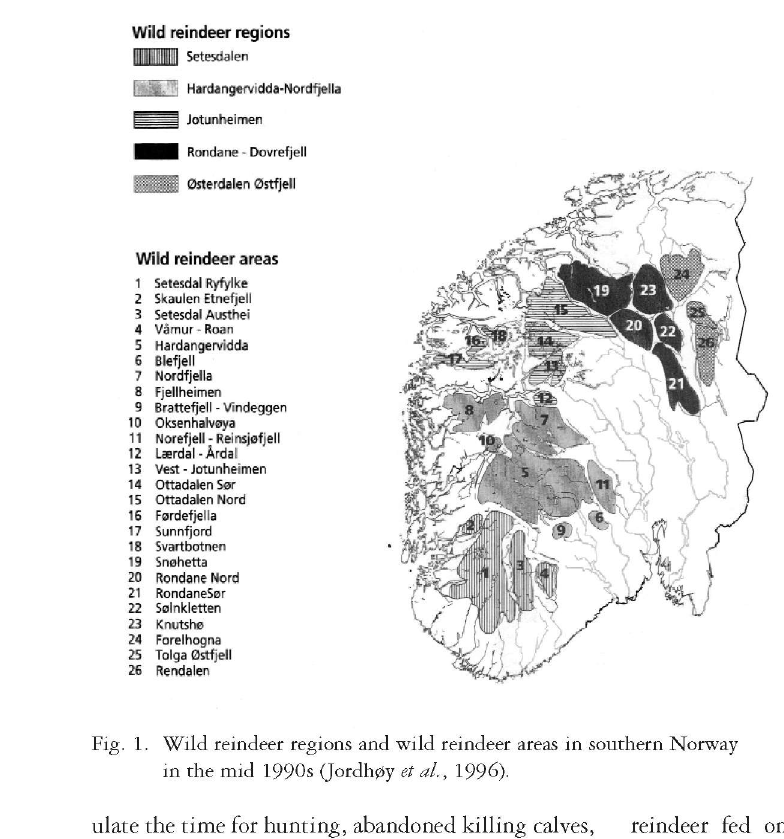
Fig. 1. Wild reindeer regions and wild reindeer areas in southern Norway in the mid 1990s (Jordh0y et at.,